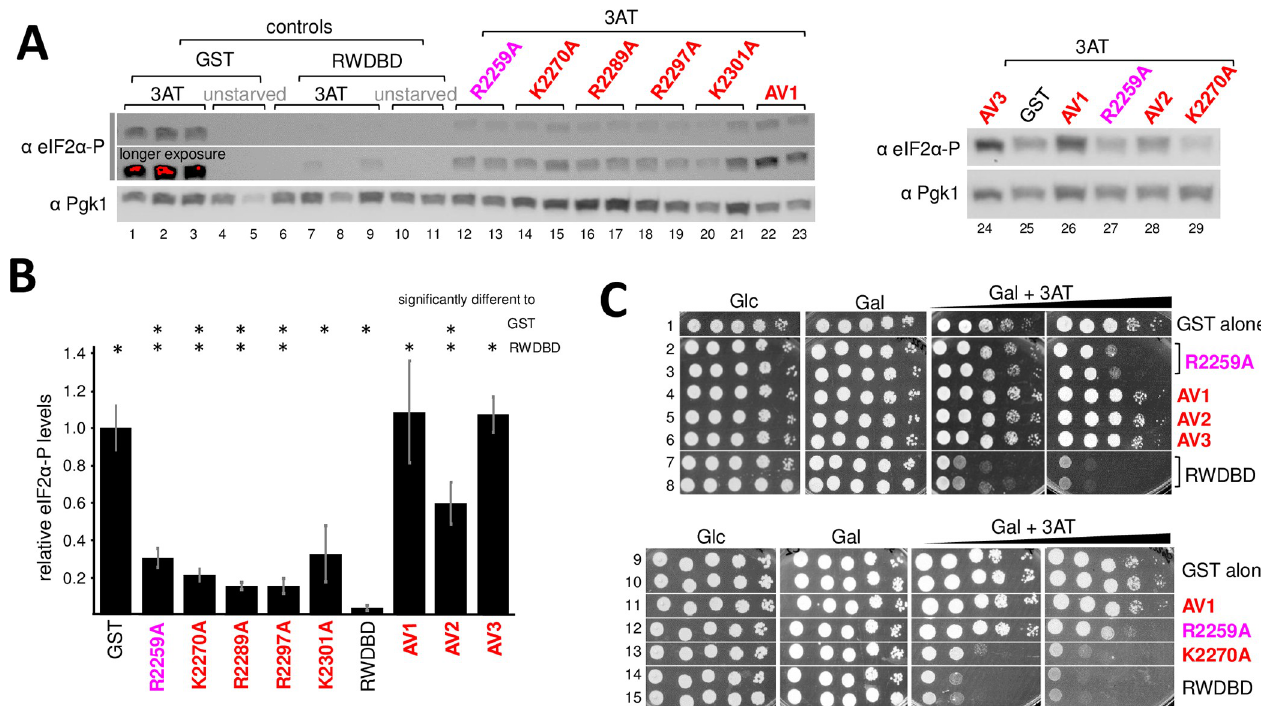
Fig 3. Analysis of multiple amino acid substitutions targeting residues that each impaired the dominant negative effect of the RWDBD. (A) Strains overexpressing RWDBD variants or GST alone as indicated, were grown to exponential phase before adding 30 mM 3AT (final concentration) for 30 min. Cells were exposed to formaldehyde before harvesting, and cell extracts were subjected to SDS-PAGE and immunoblotting using antibodies specific against phosphorylated eIF2 α (eIF2 α -P), and against Pgk1 as control for equal loading. Representative images are shown from at least 4 independent experiments. (B) The relative level of eIF2 α -P in (A), from four independent experiments, was determined as done in Fig 2, just that the eIF2 α -P signal was divided by the Pgk1 signal. Error bars indicate standard errors. Values significantly different to that of GST or RWDBD are indicated with asterisks (student two-tailed t-test, p < 0.05). (C) The strains in (A) were subjected to semi-quantitative growth assays as done in Fig 1. For medium containing Galactose and 3AT (Gal+3AT), plates containing 30 mM and 120 mM 3AT are shown (Left and right panel underneath the black triangle labelled Gal+3AT). Images are representative results for at least four independent